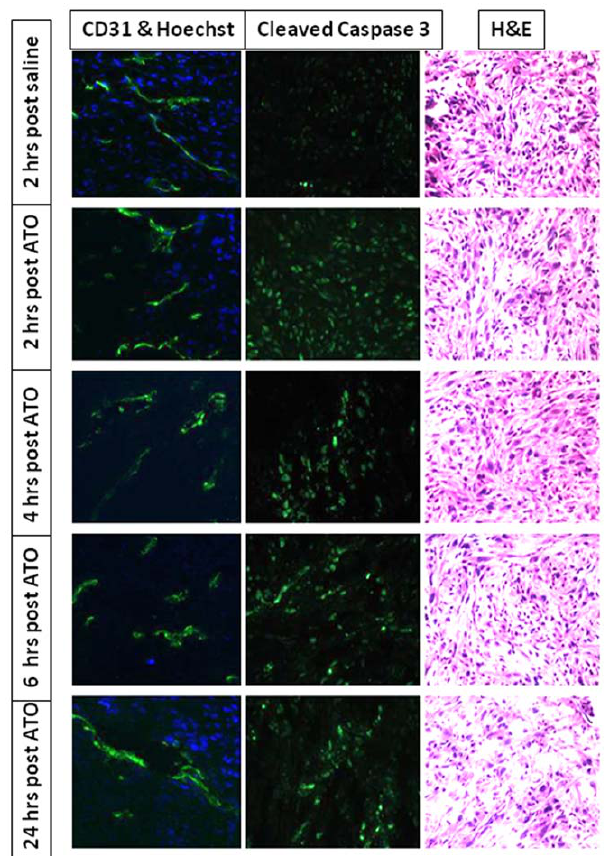
Figure 6. Histology showing vascular impairment and apopto- sis in MCF7-mCherry-luc tumors. Sections were obtained from a series of mice sacrificed at various times after ATO (8 mg/kg). Hoechst stain shows reduced perfusion 2–6 hrs following ATO and H&E stain shows increased necrosis after 24 hrs. Left column: vascular extent (CD31; green) and perfusion (Hoechst 33342; blue). Middle column: Caspase-3 activity indicating apoptosis. Right column: H&E.